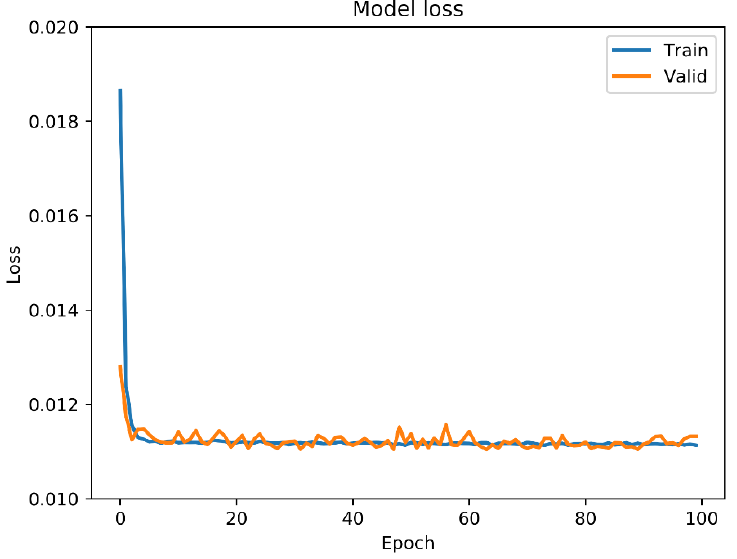
Figure 3. The training model loss plotted along the epochs.